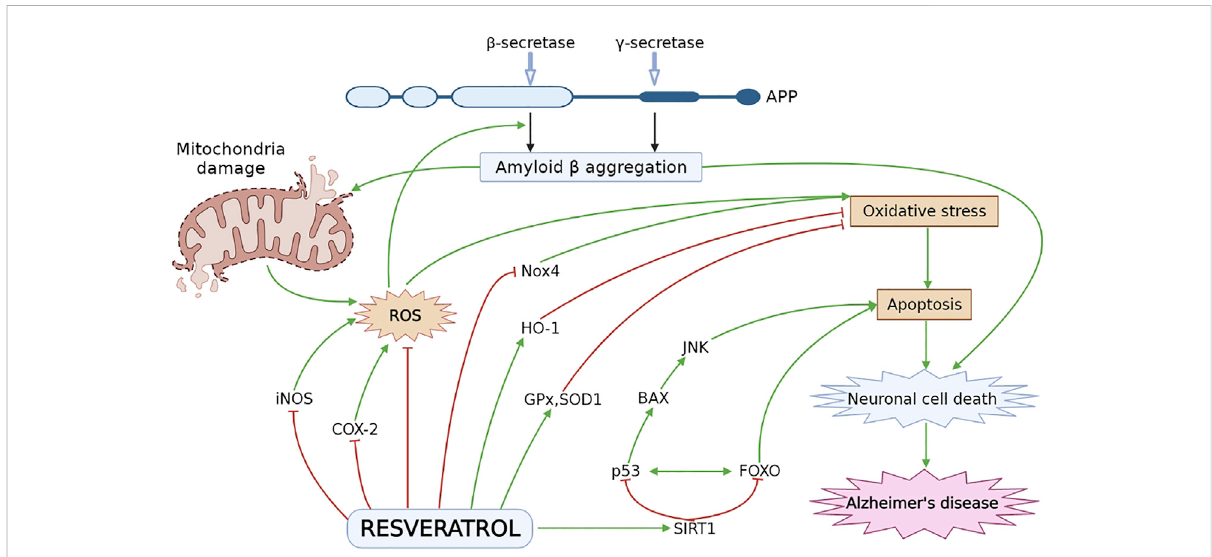
FIGURE 2 Neuroprotective effect of RES in AD pathogenesis. Oxidative stress leads to formation of ROS especially, iNOS and COX-2, which plays a vital roleincellularapoptosis.RESdecreasesthelevelofiNOSandCOX-2andstimulatetheHO-1leveltoinhibitoxidativedamage.RESreducesoxidative stress by decreasing the Nox4 expression and elevating the level of ROS inactivating enzymes, i.e., SOD1 and GPx. RES activates SIRT1 followed by inhibition of p53 and FOXO to attenuate BAX and JNK dependent apoptosis and neuronal cell death. APP, amyloid precursor protein; BAX, Bcl- 2-associated X protein; COX-2, cyclooxygenase-2; HO-1, heme oxygenase-1; iNOS, inducing nitric oxide synthase; JNK, Jun N-terminal kinases; Nox4, NADPH oxidase 4; ROS, reactive oxygen species; SIRT1, sirtuin